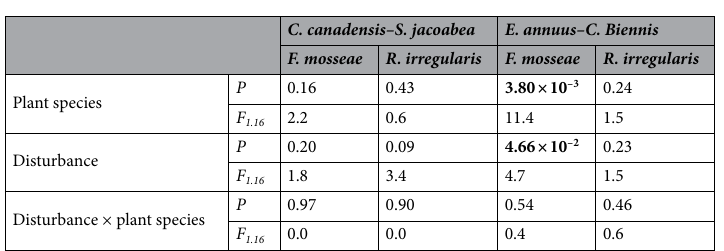
Table 4. Significance of effects of plant and disturbance, and their interaction on the abundance of different arbuscular mycorrhizal fungal taxa in root samples of the perennial and annual plant species co-occurring in the experimental pots. F ‐ values (F) and levels of statistical significance ( p -value ranges, P ) as per two-way ANOVAs are shown (n = 5). Significant results are stated in